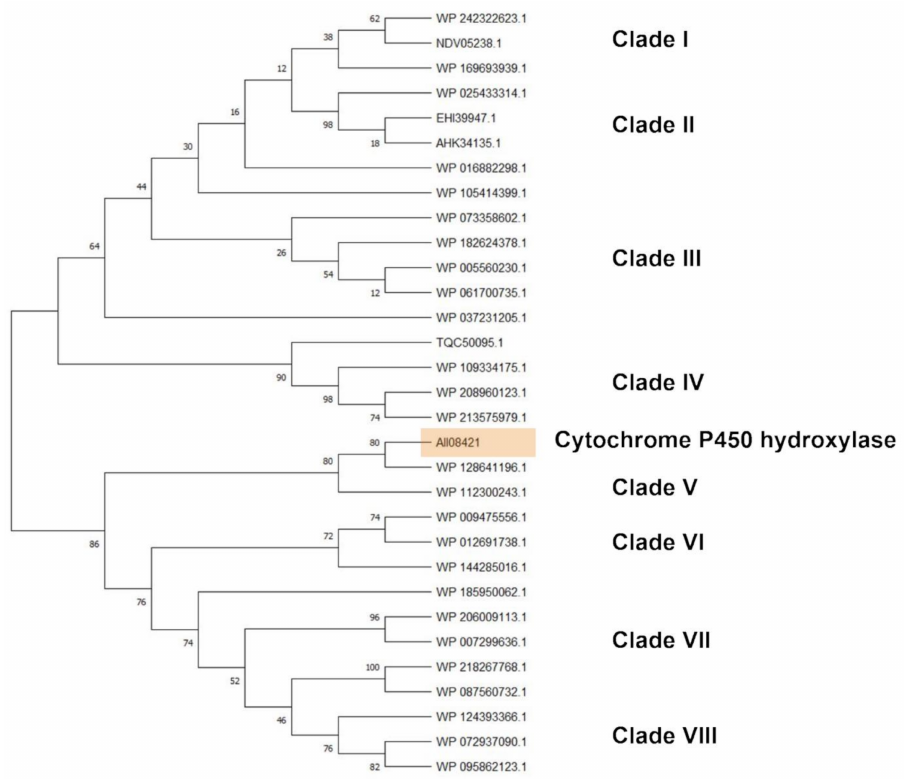
Figure 9. Subtree clusterization of HIT sequences identified by cytochrome P450 hydroxylase input gene putatively involved in C-C backbone plastic degradation. Marked box evidences the reference input